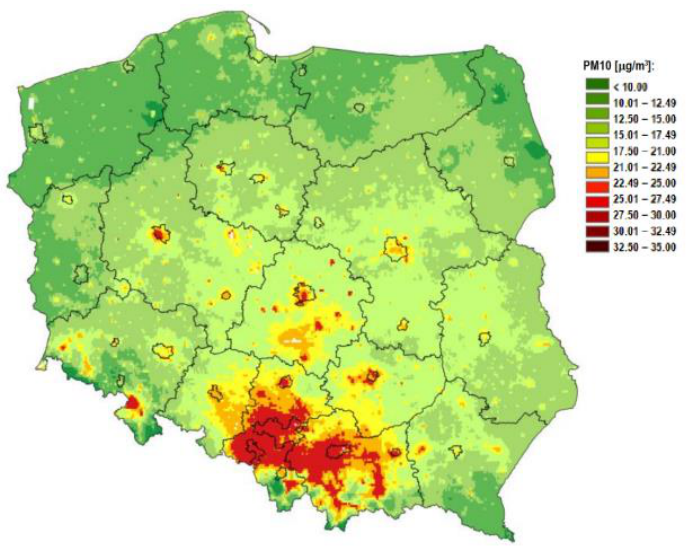
Figure 2. Spatial distribution of PM 10 concentrations across Poland in 2019 [20]. Reprinted with permission from [20]. Copyright 2019, State Environmental Monitoring.